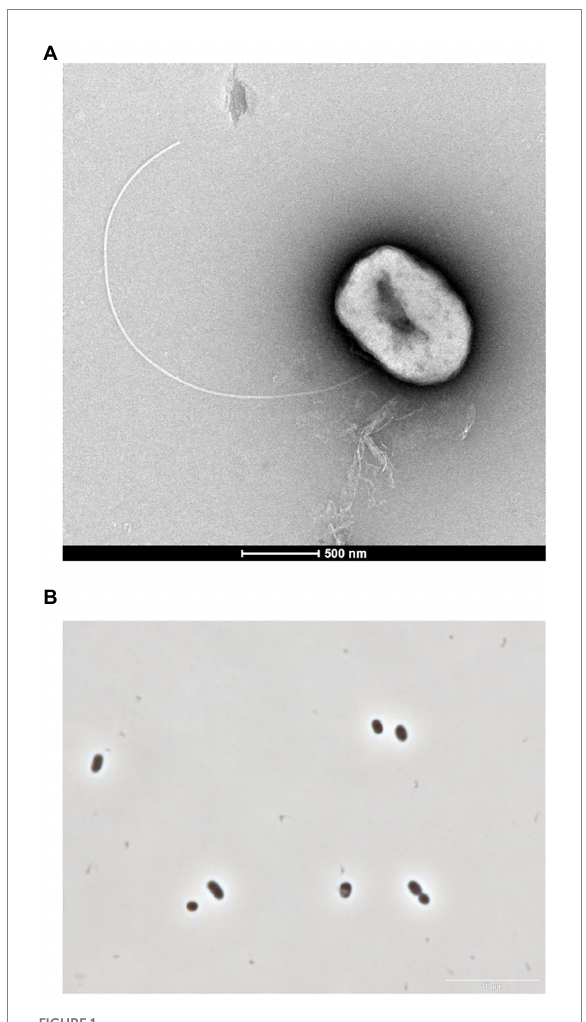
FIGURE 1 (A) Transmission electron micrograph showing a cell of GF1 T . Scale bar represents 0.5 μ m. (B) Phase contrast micrograph of strain GF1 T . Scale bar represents 10 μ